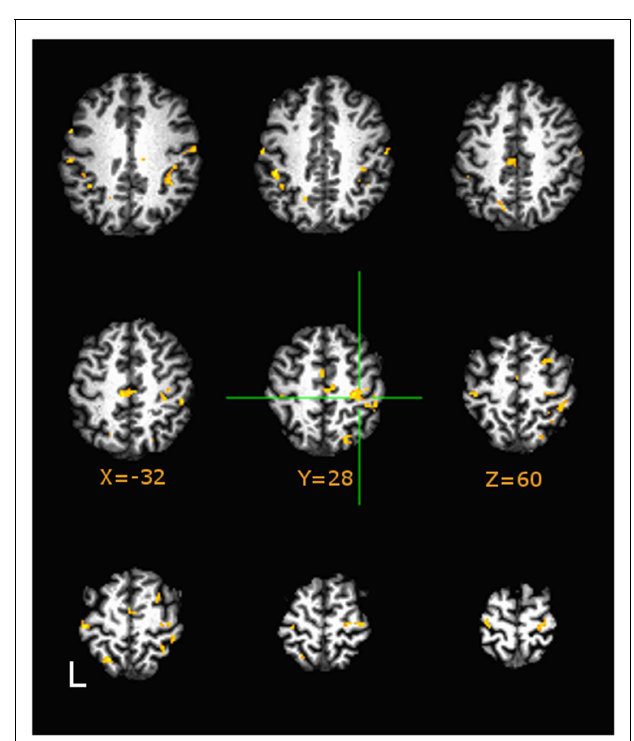
FIGURE 4 | Group differences in area-under-curve (AUC) group comparisons between Sedentary and Fit middle age adults on tapping task at p < 0.05, Image montage is in axial presentation of supra-callosal MNI152 registered slices separated by 6mm . False Discovery Rate ( q < 0.05) corrected comparisons are presented in color (Hues: orange indicates more positive values in Sedentary adults, blue indicates vice-versa). Sedentary middle age adults showed significantly higher values of AUC (corresponding to positive BOLD) in right sensorimotor